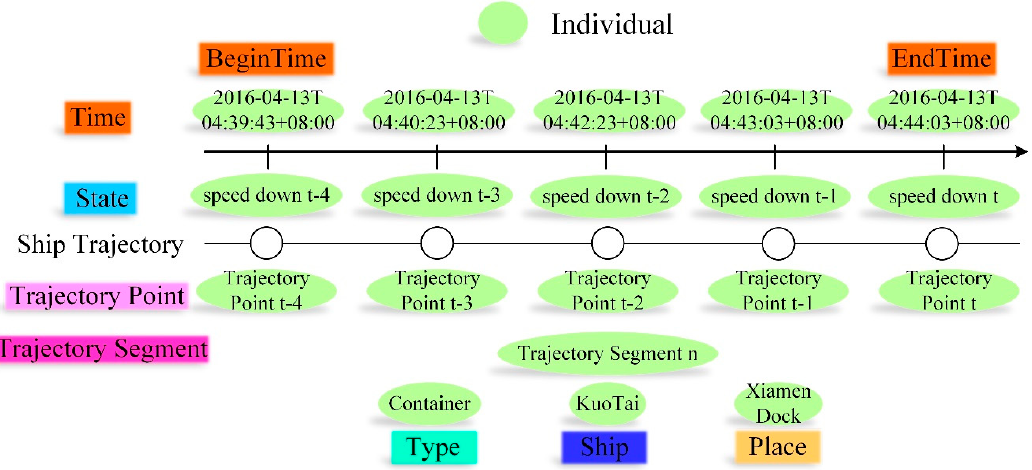
Figure 8. Running example: the Individuals after the State recognition when the ship arrives at a dock. Every ship trajectory point has a speed down Individual .